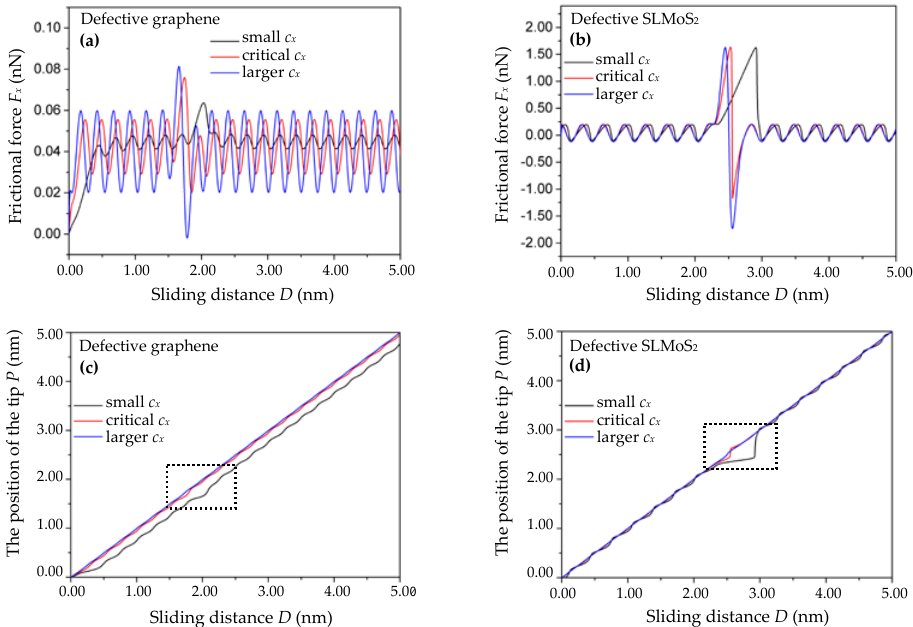
Figure 6. The frictional force F x vs. the sliding distance D curves of the monovacancy-defective graphene ( a ) and SLMoS 2 ( b ) with di ff erent spring constants c x of the pulling spring. The position of the single-atom tip P vs. the scanning distance D curves of the monovacancy-defective graphene ( c ) and SLMoS 2 ( d ) with di ff erent c x . The small, critical, and larger c x of the monovacancy-defective graphene in Figure 6a is 0.18, 0.91, and 4.55 N / m, respectively. The small, critical, and larger c x of the monovacancy-defective SLMoS 2 in Figure 6b is 3.44, 17.18, and 85.9 N / m, respectively. The relations of the position of the single-atom tip P